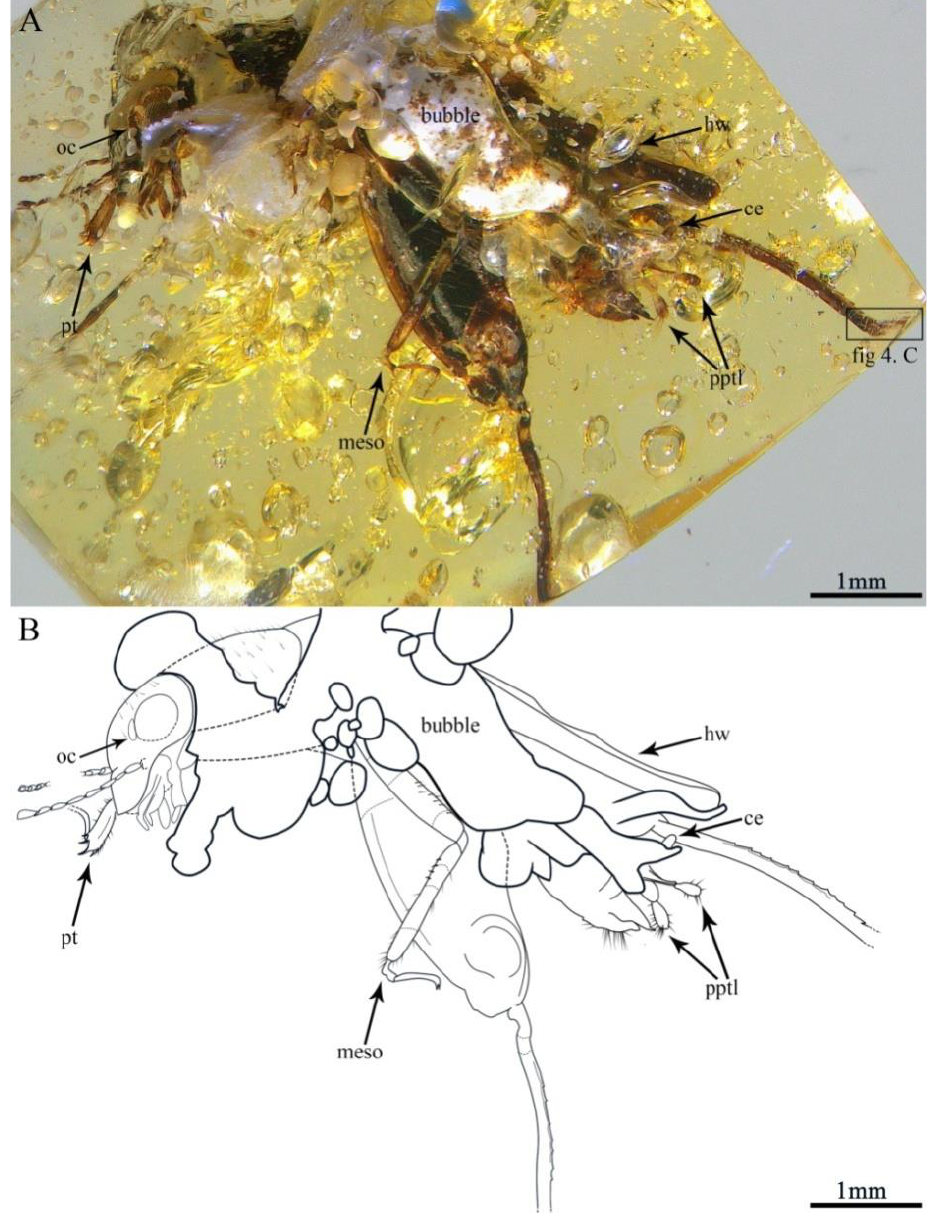
Figure 3. Habitus of Magnidactylus gracilis sp. nov., holotype (SICAU–A–085). ( A ) Photograph in lateral view and ( B ) line drawing in lateral view.